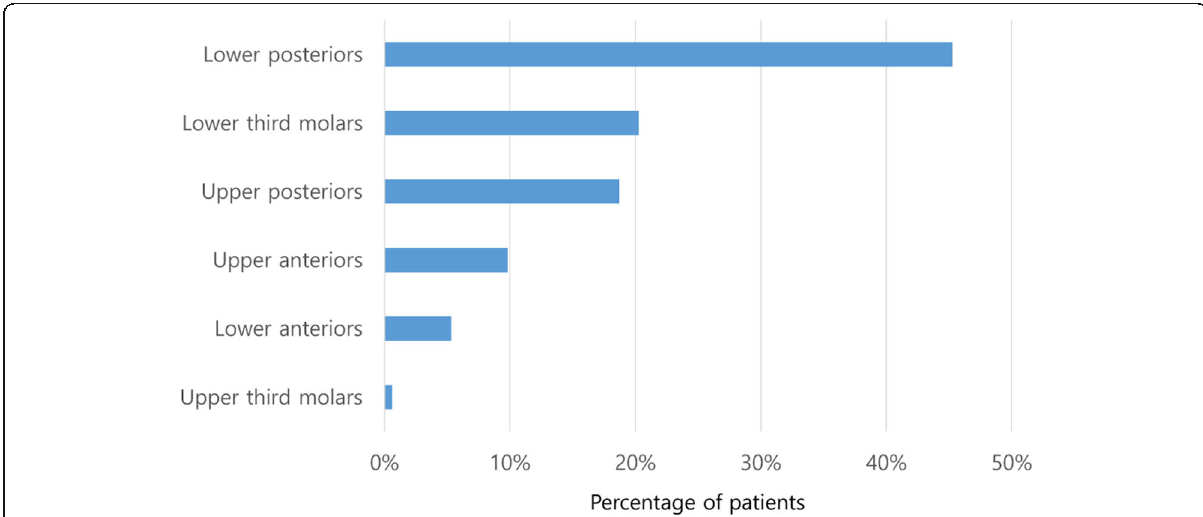
Fig. 2 Teeth involved in maxillofacial space infection. The most frequently involved teeth were the lower posteriors, followed the by lower